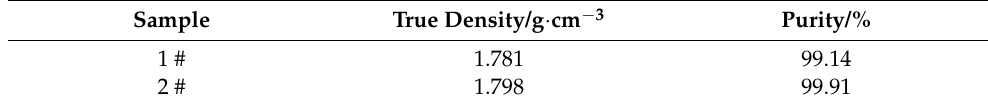
Table 2. The true density and purity of different RDX crystals.